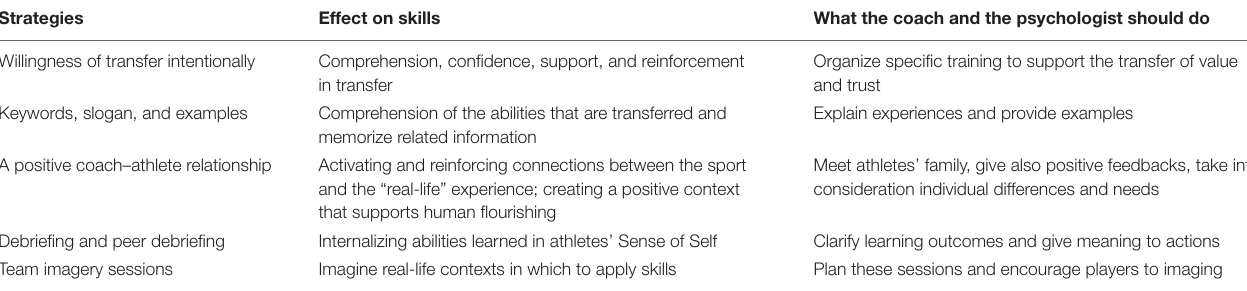
TABLE 1 | Strategies used by coaches to promote skill transfer from sports to health management.